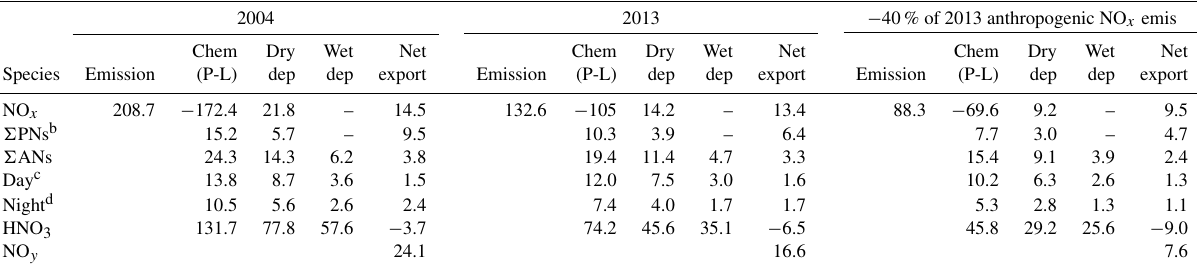
Table 3. Monthly NO y budget in the boundary layer (<1.5km) of the Southeast US during July–August of 2004, 2013, and a scenario with 40% reduction of anthropogenic NO x emissions of 2013 a .